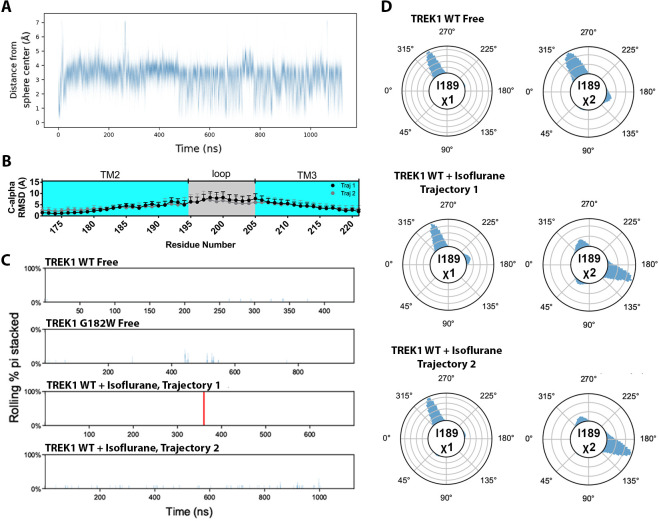
Additional molecular dynamics simulation data.(A) Distance of the center of geometry of the isoflurane ligand from the center of the spherical restraint, of radius 7A, as a function of simulation time during TREK1 wildtype (WT) + isoflurane trajectory 2 (B) C-alpha limited per residue RMSD within the TREK1 TM2/TM3 loop from TREK1 WT + isoflurane trajectory 1 (black symbols) or trajectory 2 (gray symbols), as compared with the final frame of the equilibrated TREK1 WT-free simulation. (C) Pi-stacking plots, as described in the Figure 6 legend, for the F185/F214 residue interaction in the unliganded neighboring TREK1 subunit. (D) Side chain χ 1 and χ 2 dihedral angle residence plots for mTREK1 I189 during the TREK1 WT-free (top) and TREK1 WT + isoflurane simulation trajectories (middle, bottom).